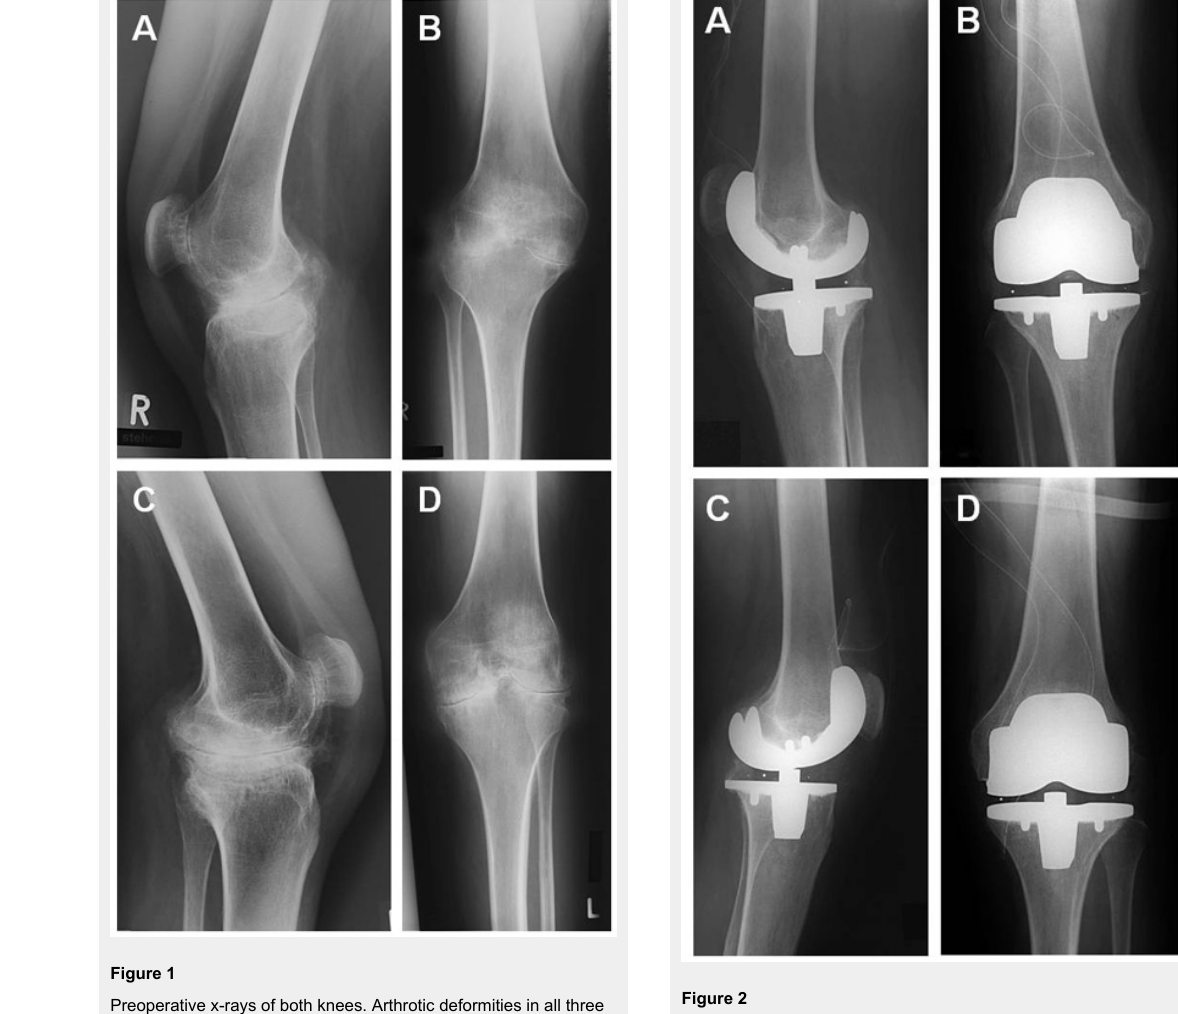
X-rays of both knees after surgical implantation of prostheses. (a) Right knee lateral view (b) Right knee anterior-posterior view (c) Left knee lateral view (d) Left knee anterior-posterior